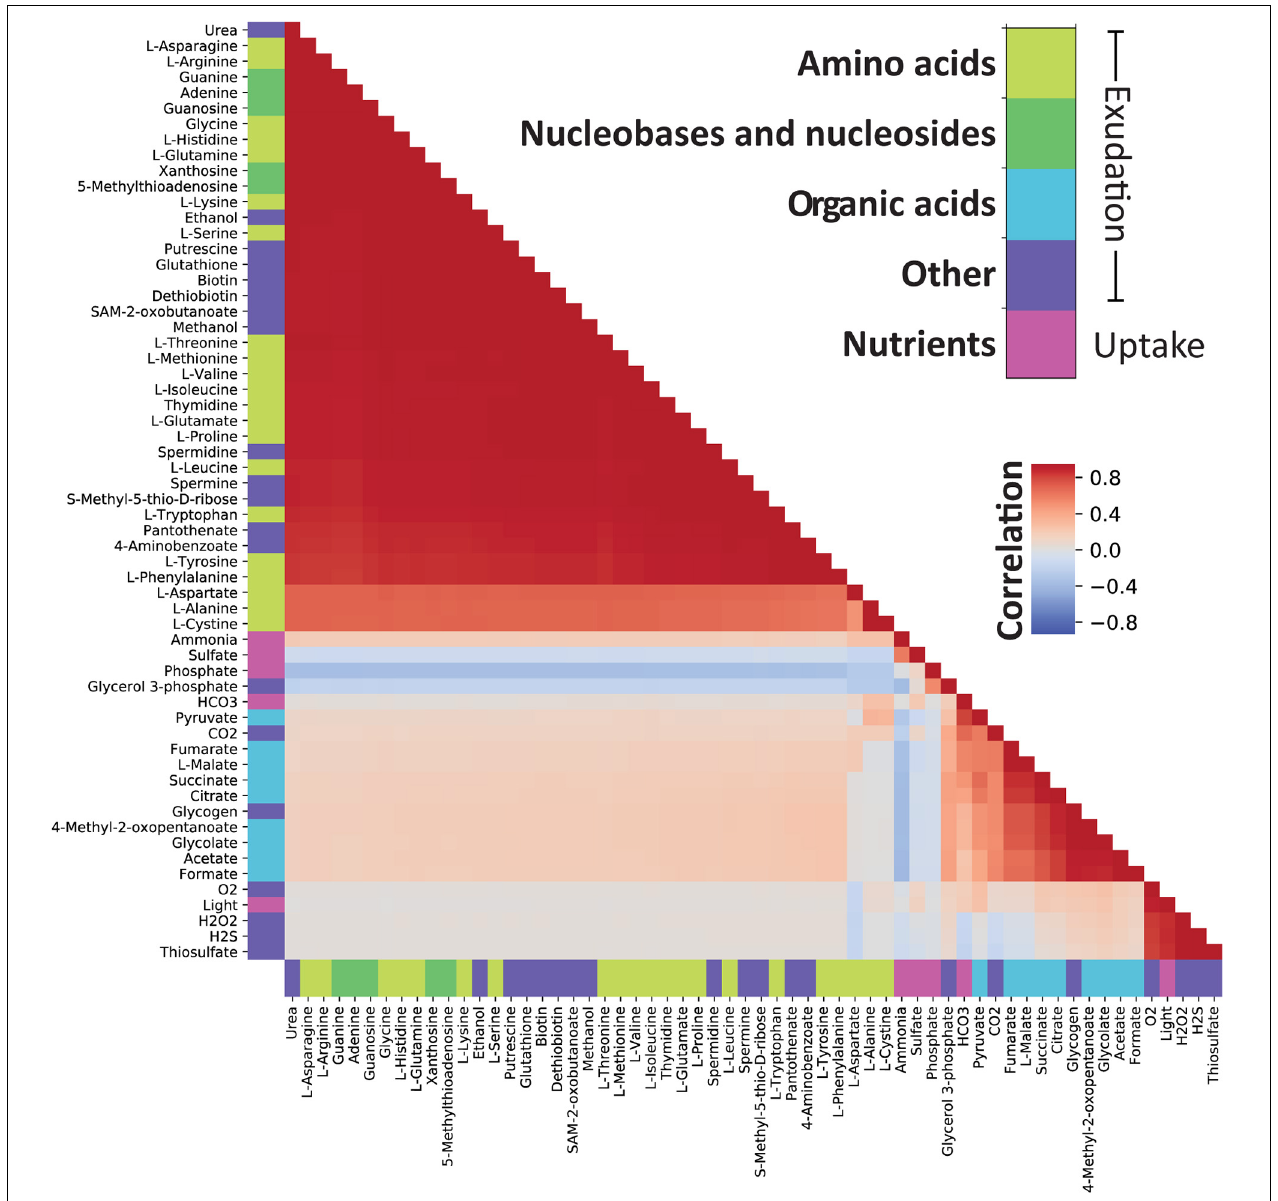
FIGURE 5 | Correlations between maximal FVA values demonstrate which compounds can be secreted in similar environmental conditions. There are two clearly correlated groups of compounds: The first group comprises nucleobases, nucleotides, and amino acids while the second contains organic acids, glycogen and glycerol 3-phosphate. From the correlation of each of these groups with the uptake bounds on ammonium and phosphate we observe that these factors determine which of the groups can be secreted. Note that the environmental constraints have been converted to positive values prior to calculating the